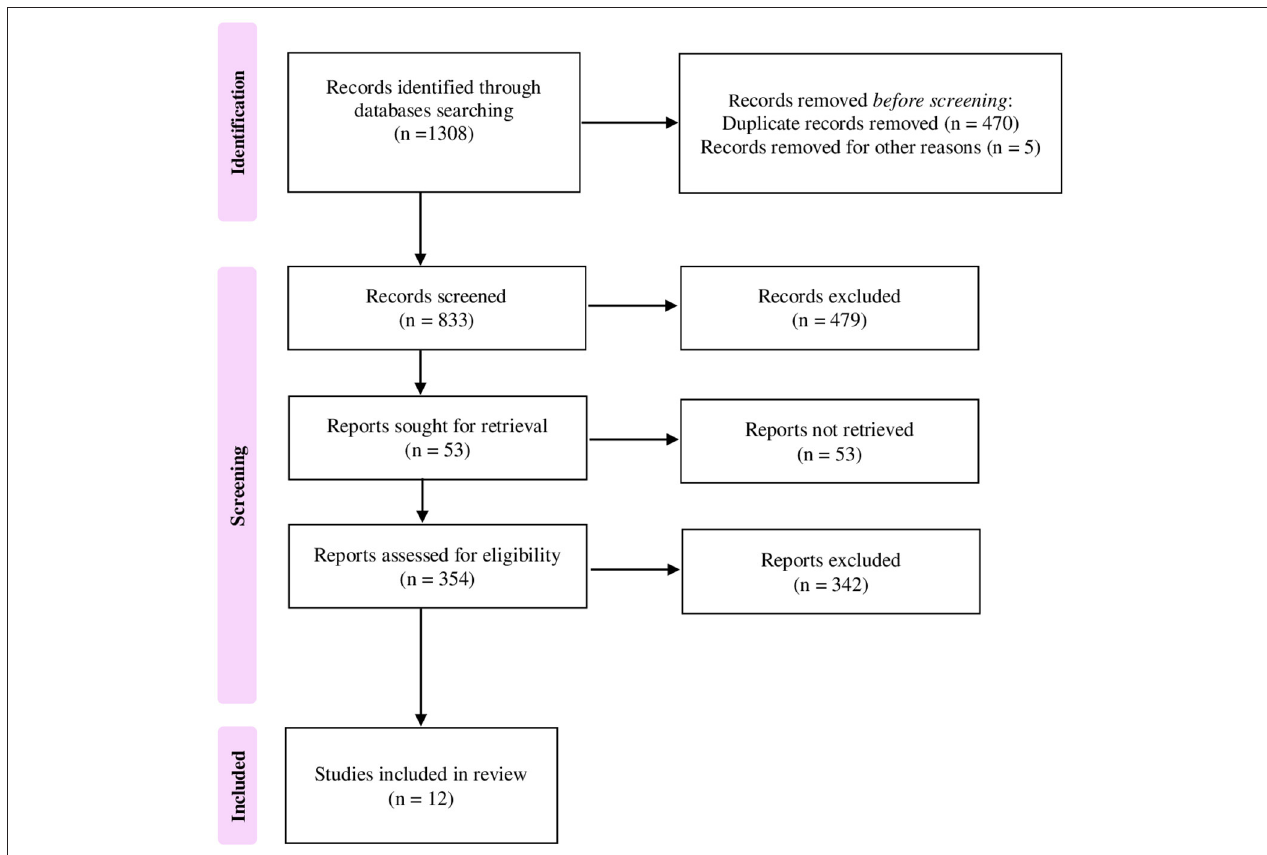
FIGURE 1 | Preferred Reporting Items for Systematic Reviews and Meta-analyses (PRISMA) flow chart illustrating the number of studies at each stage of the review.